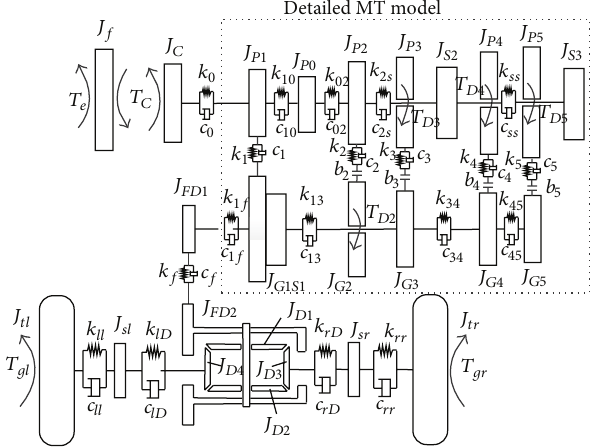
Figure 16: The torsional vibration model of vehicle driveline with detailed MT model for the first speed.